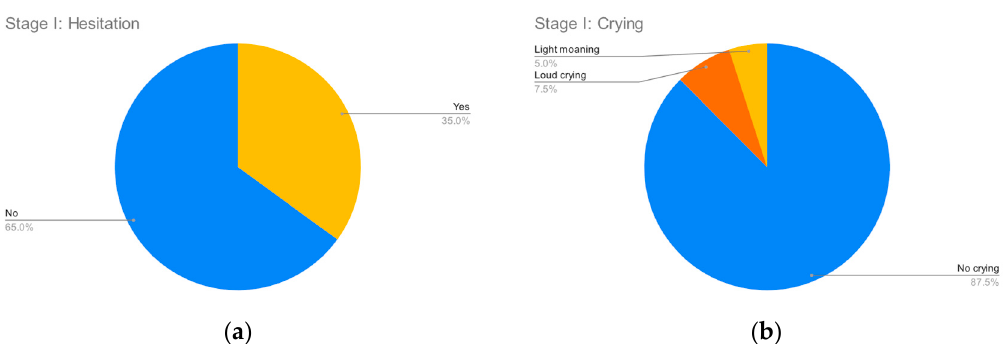
Figure 2. Stage I parameters. ( a ) Hesitation; ( b ) Crying.